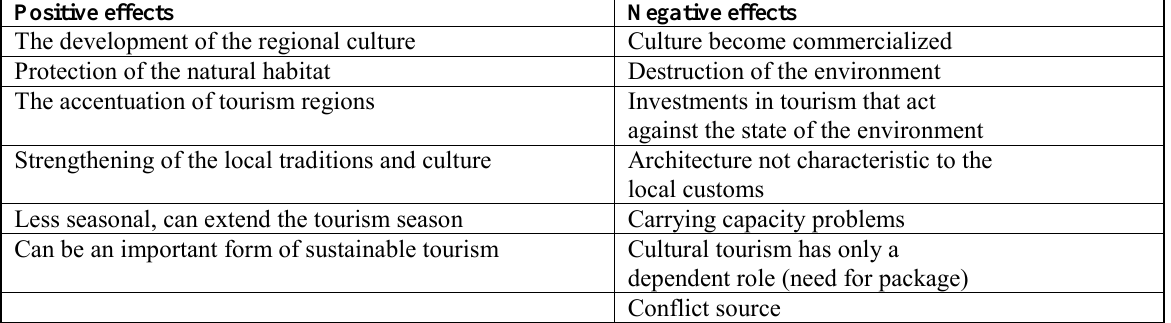
Table 2: Positive and negative effects/impacts of cultural